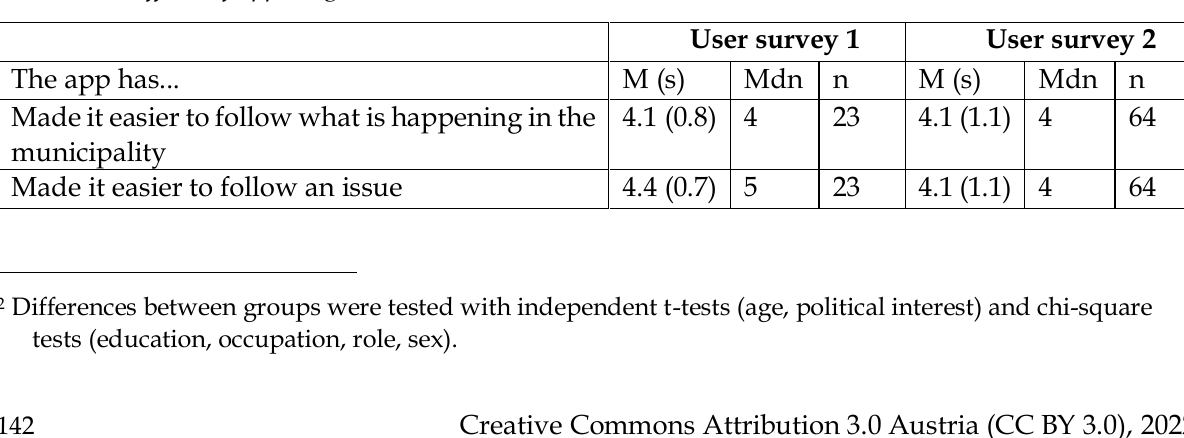
Table 4. The effects of app